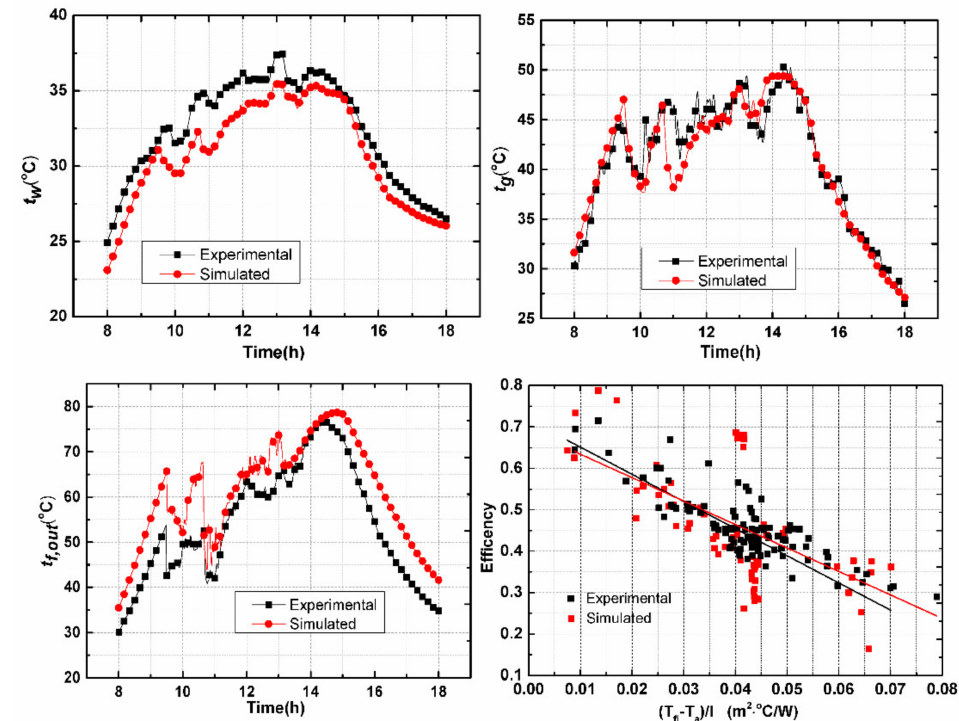
Figure 3. Comparison of temperatures and efficiency between experiment and